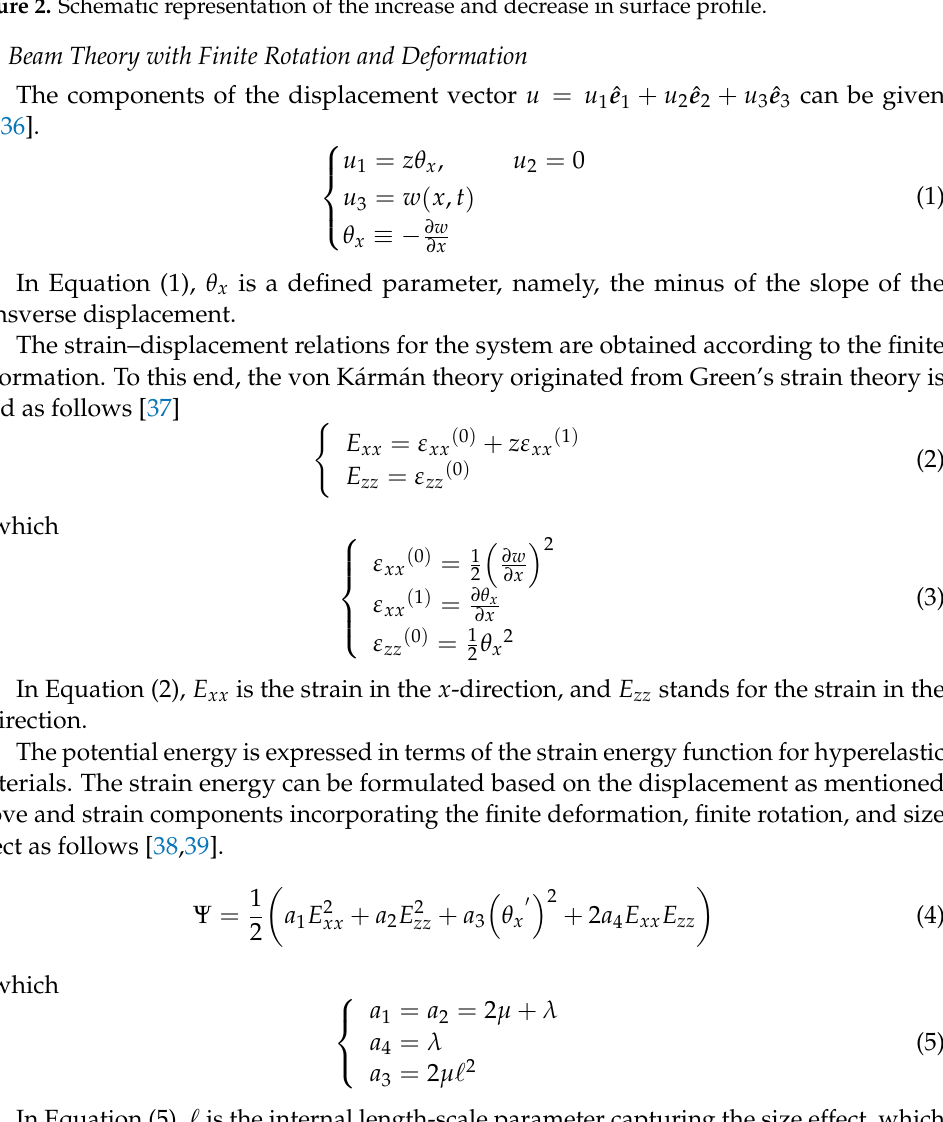
Figure 2. Schematic representation of the increase and decrease in surface